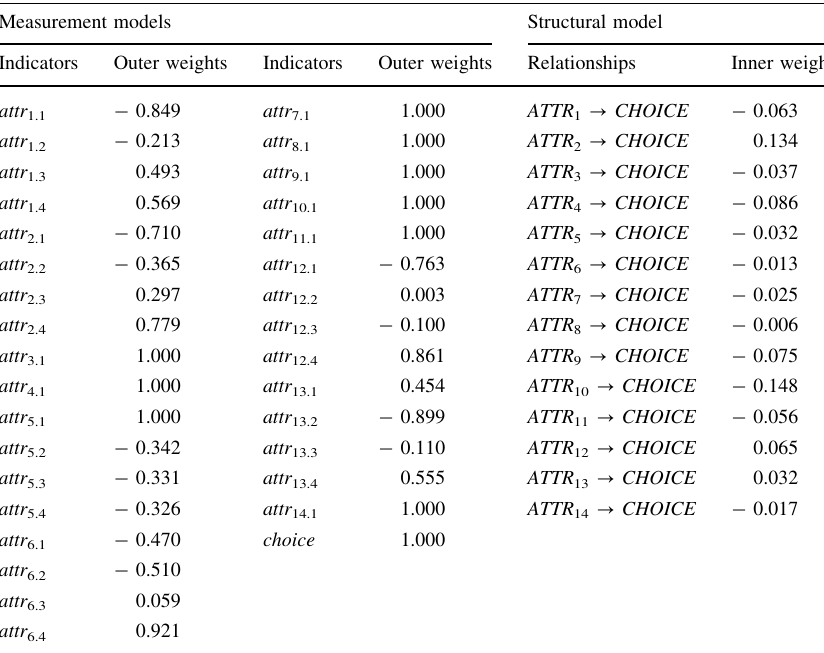
Table 1 PLS-SEM